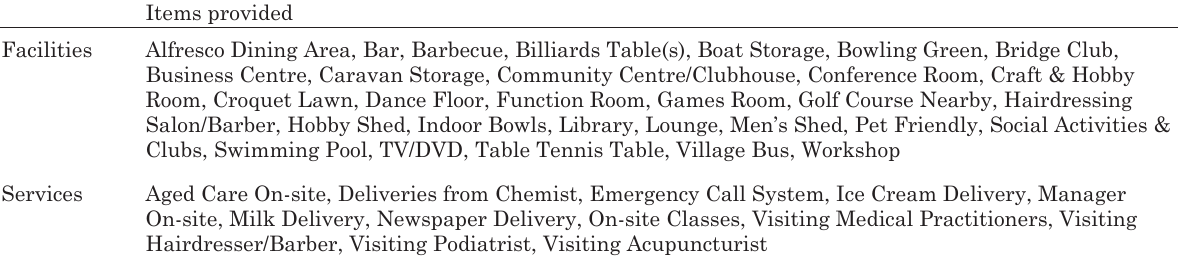
Table 1. Facilities and services provided in the village Items